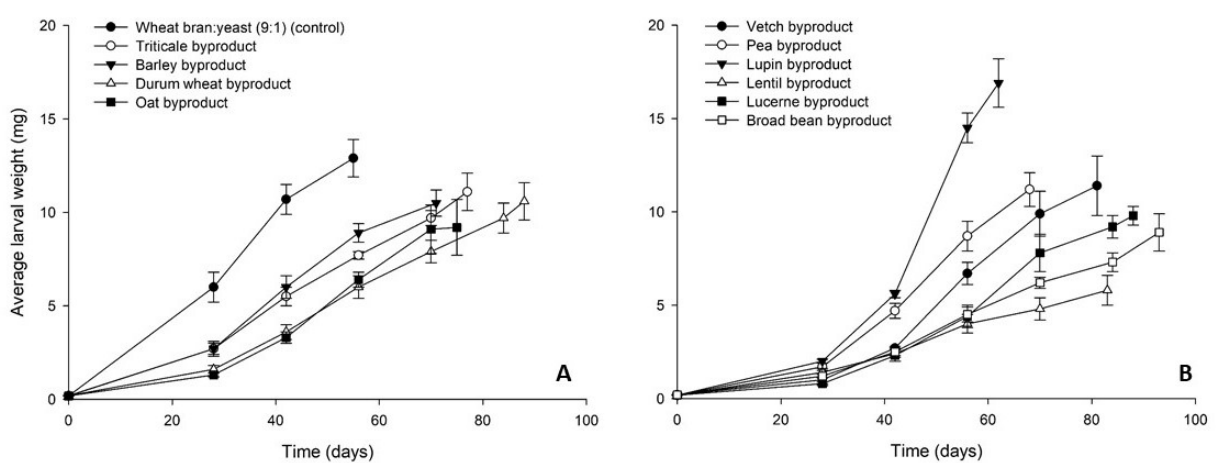
Figure 4. Average larval weight (mg) of Alphitobius diaperinus larvae reared on byproducts of the seed cleaning process of